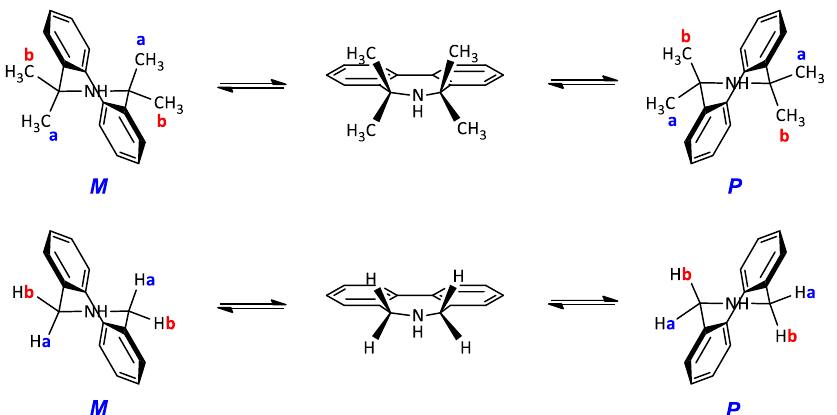
Figure 1. Conformational torsional equilibrium of tetramethyl biphenylazepine 2 (top) and unsubstituted biphenylazepine 1 (bottom).